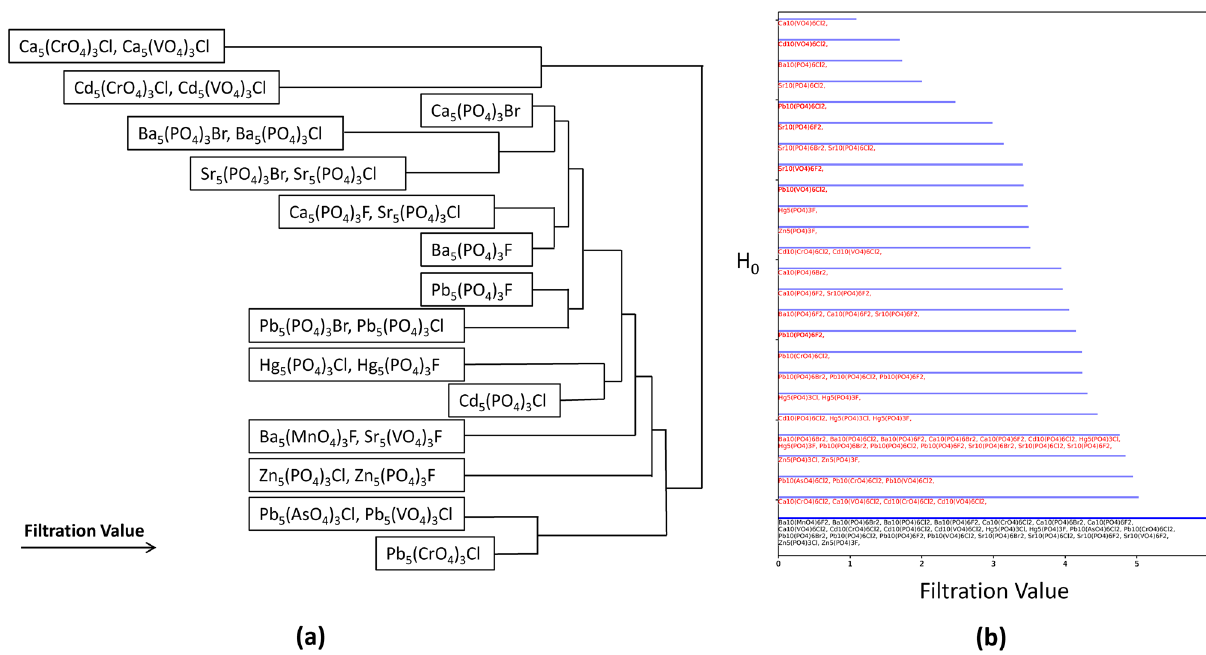
Figure 4. ( a ) The classifications extracted from the TDA derived barcode. As the filtration value increases, additional relationships picked up by the barcode appear. The similarity of the compounds decreases as the filtration value at which their relationship appears increases. This allows us to identify not only classifications at a given criteria but also the degree of similarity within those classifications. ( b ) The final barcode corresponding to this